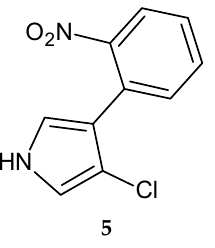
Figure 2. Structure of pyrrolnitrin 5 .